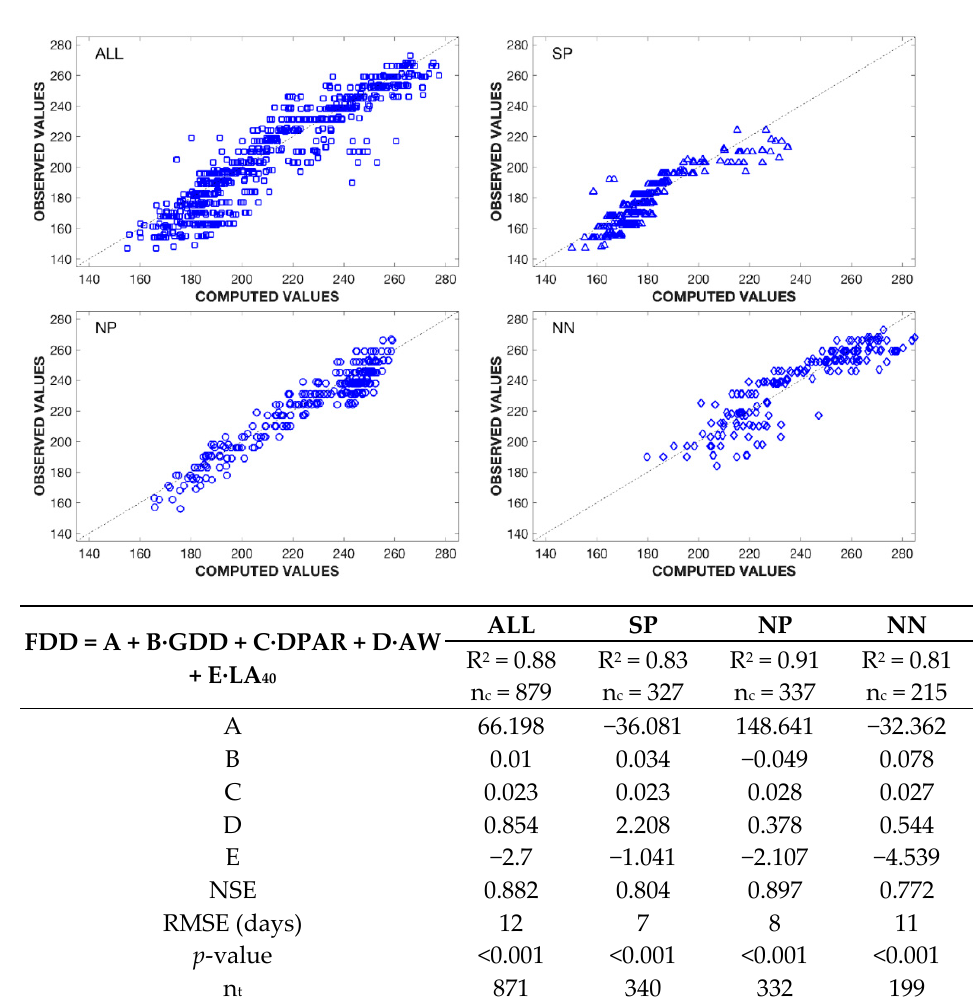
Figure 4. Performance of the multilinear regression (MLR) models for estimating fruit development days (FDD) from total growing degree days (GDD), total daily photosynthetically active radiation (DPAR), anthesis week (AW, expressed as the number of the week), and leaf area (LA 40 ) estimated from those leaves with a central nerve length longer than 40 cm. The evaluated MLR models with coefficients A to E were obtained individually for each location studied (SP, NP, and NN), but also an MLR model common to all locations (ALL) was fitted. The n c and n t indicate the number of data used for the model calibration and testing, respectively.